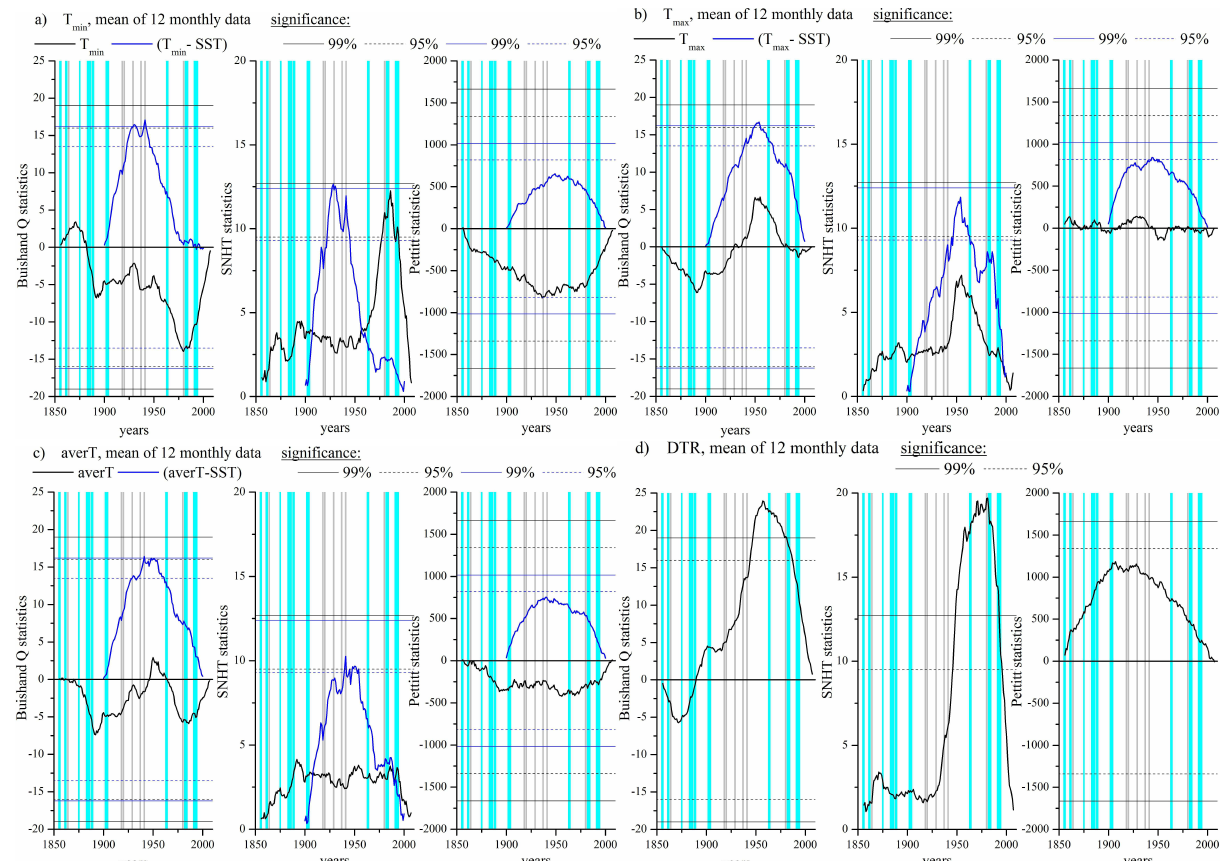
Figure 17. Lisbon: same as Fig. 13a–d but for the corrected series.